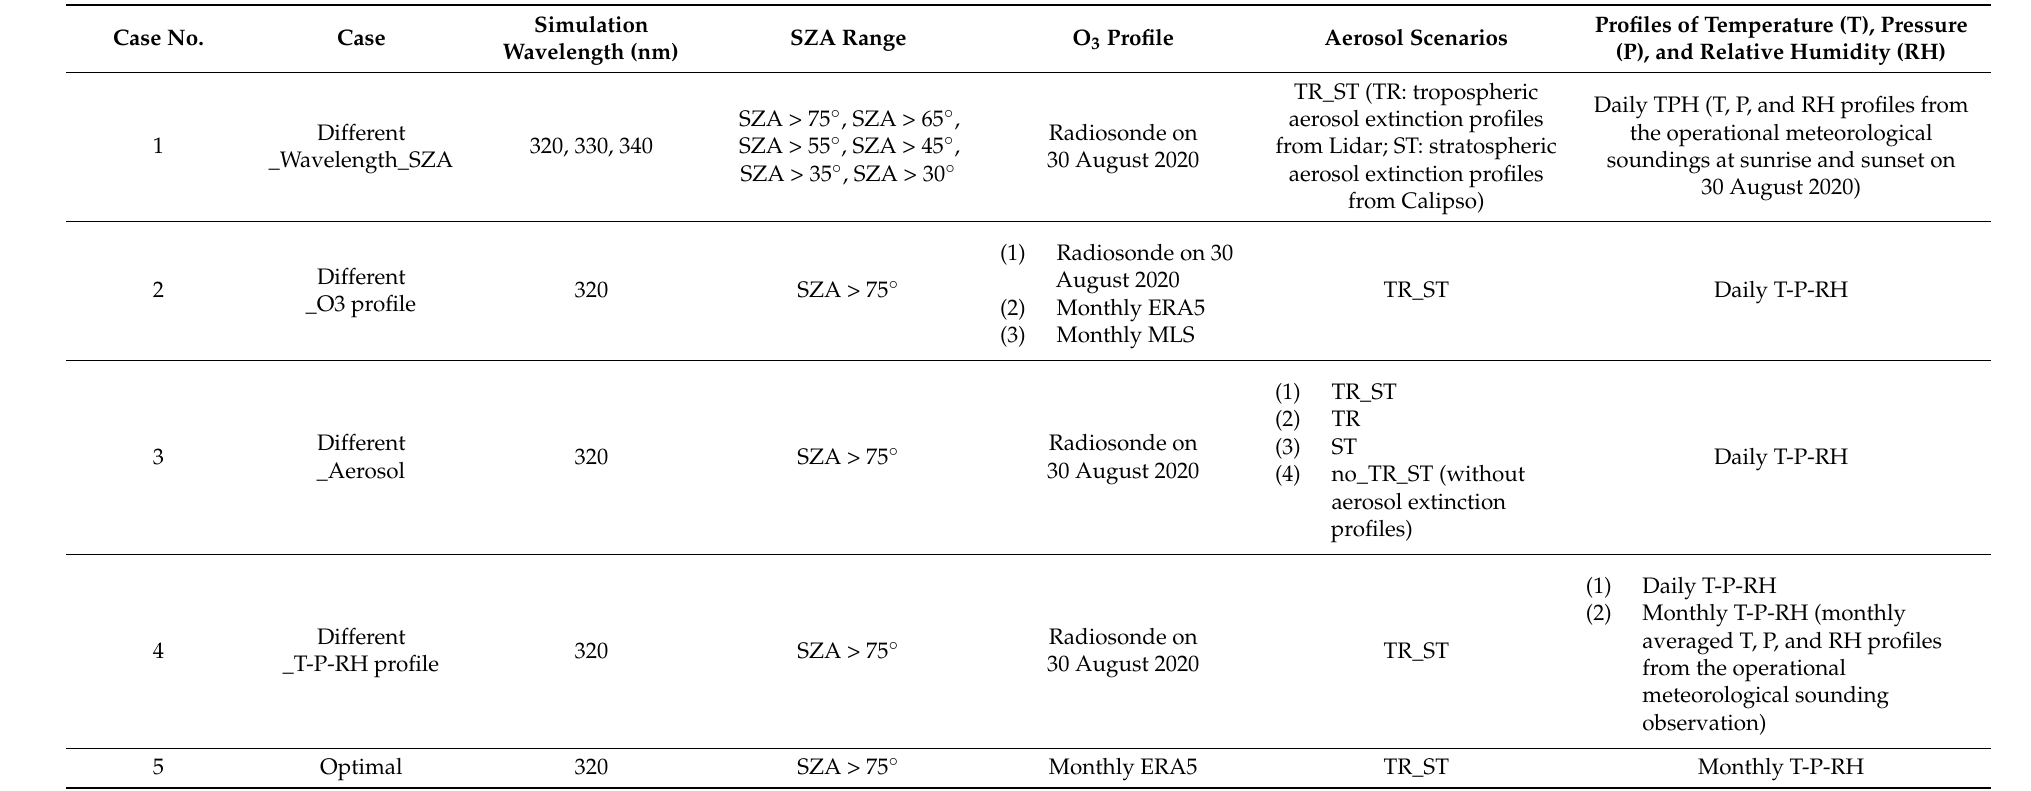
Table 1. Parameters used for the O 3 AMF simulations 1